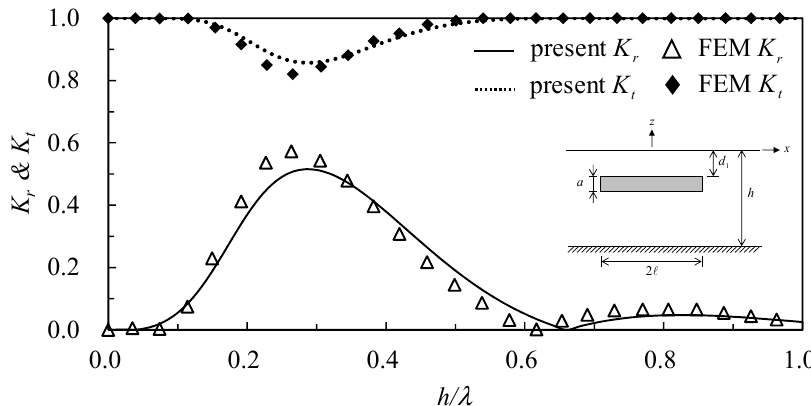
λ , for a fixed underwater plate